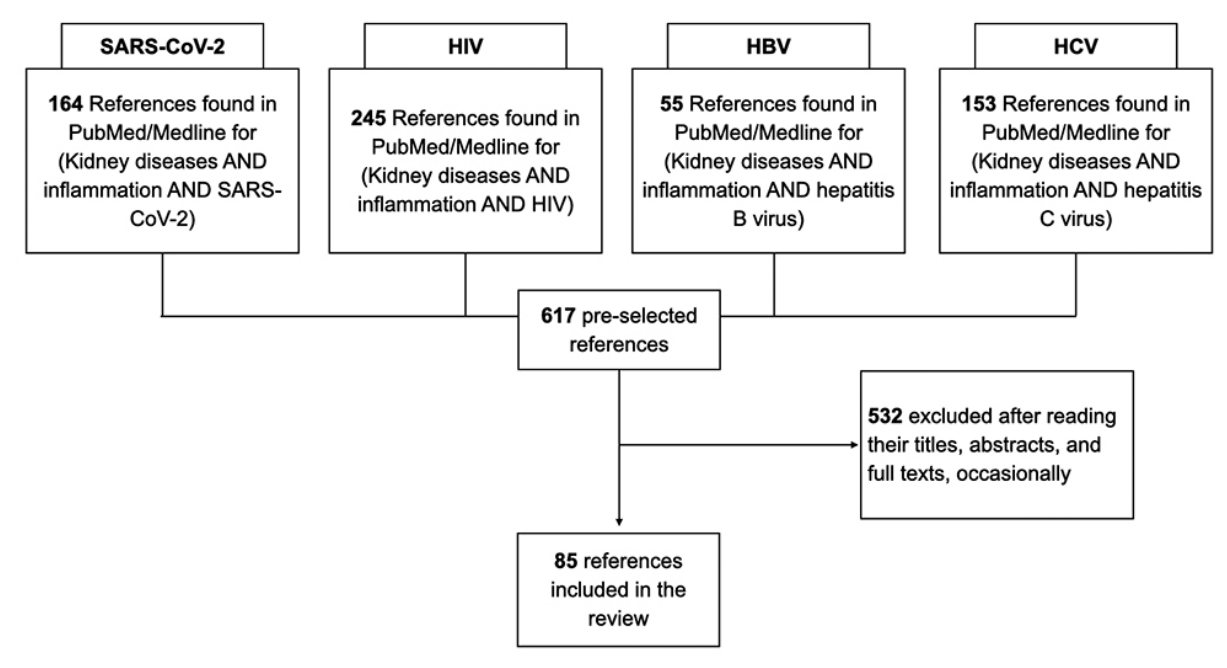
Figure 1. Article selection flow chart. HIV: human immune deficiency virus; HBV: hepatitis B virus; HCV: hepatitis C